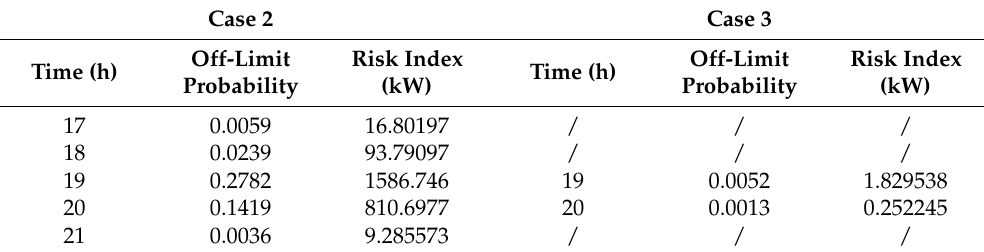
Table 7. Risk assessment results of branch